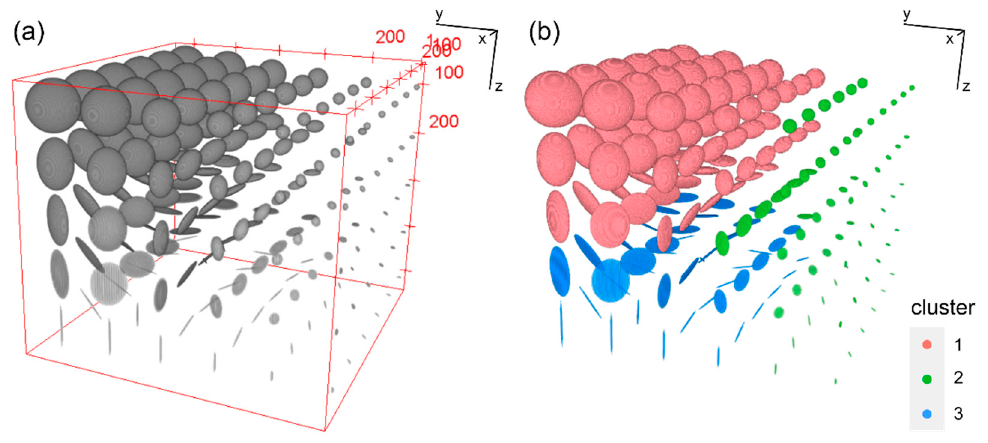
Figure A2. 3D visualization of the standard sample ( a ) and clustered grains ( b ).